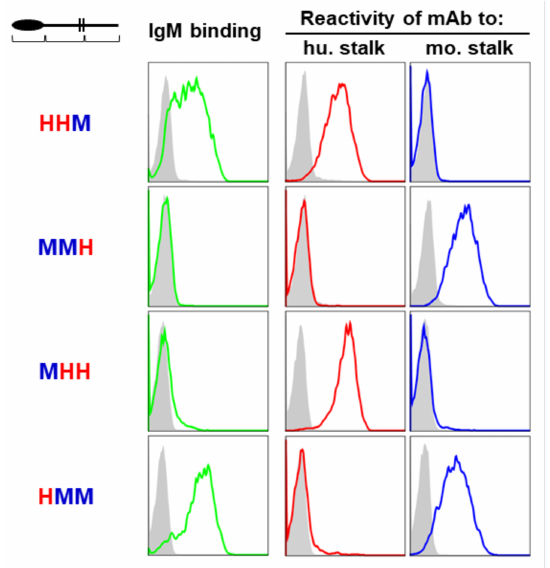
Figure 3. IgM binding of human/mouse chimeric Fc µ Rs. BW5147 cells stably expressing Fc µ R composed of Ig-like domain, stalk region and transmembrane/cytoplasmic tail (top left) of either human (H) or mouse (M) origin (left) were incubated with TEPC183 IgM κ for IgM binding (green lines), HM14 mAb to the stalk region of human Fc µ R (hu. Stalk; red lines) or MM3 mAb to the stalk region of mouse Fc µ R (mo. Stalk; blue lines), before developing with PE-labeled goat anti-mouse Ig antibodies and analyzing by flow cytometry. Note that IgM binding was only observed with chimeric receptor containing human-derived Ig-like